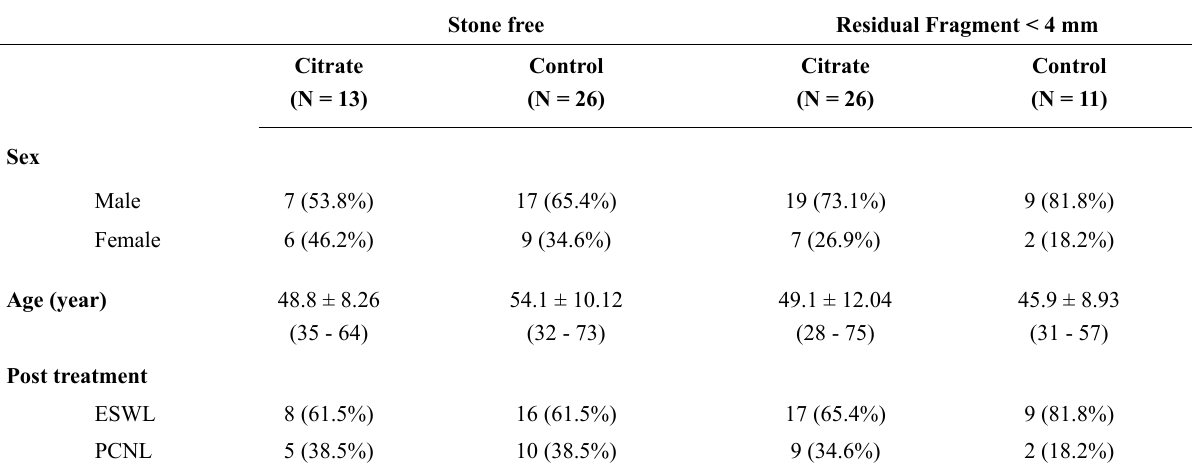
Table 1 - Profiles of patients at